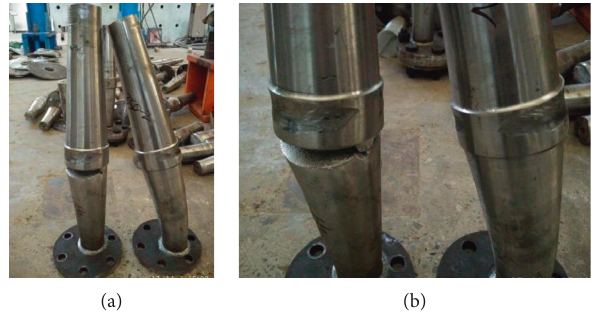
Figure 9: Failure form of specimen